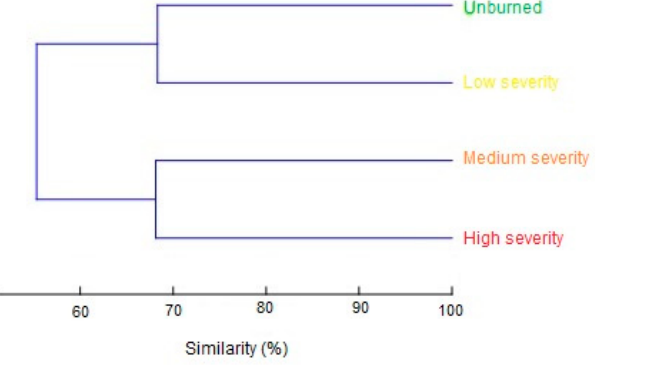
Figure 3. Dendrogram of species composition similarity at sites affected by different degrees of fire severity.